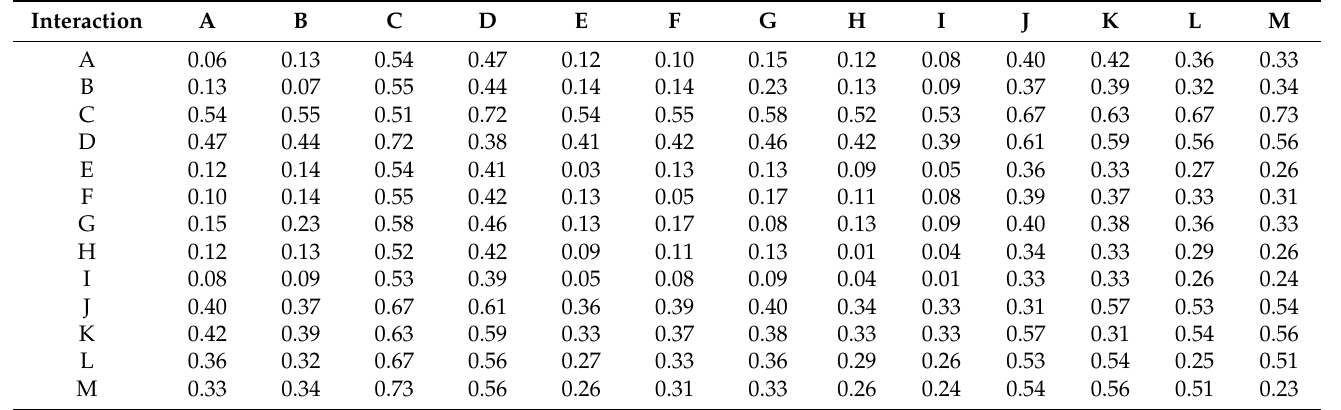
Table 2. Interaction analysis of influencing factors of the spatial distribution of ethnic minority villages in Fujian